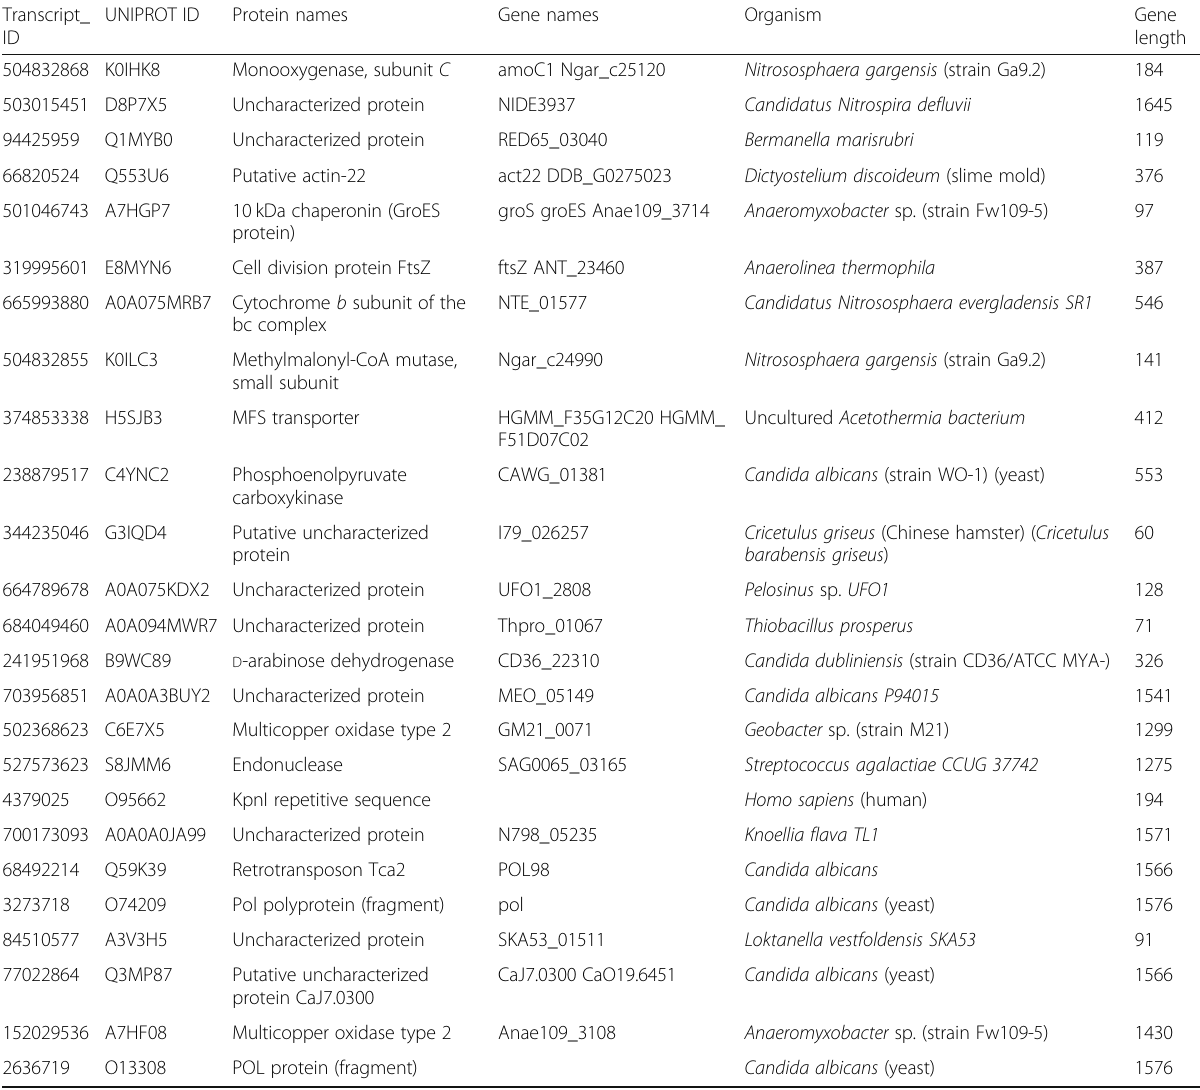
Table 2 Detailed description of the top 25 high expressed genes in M1 compared to O1 ( p value ≤